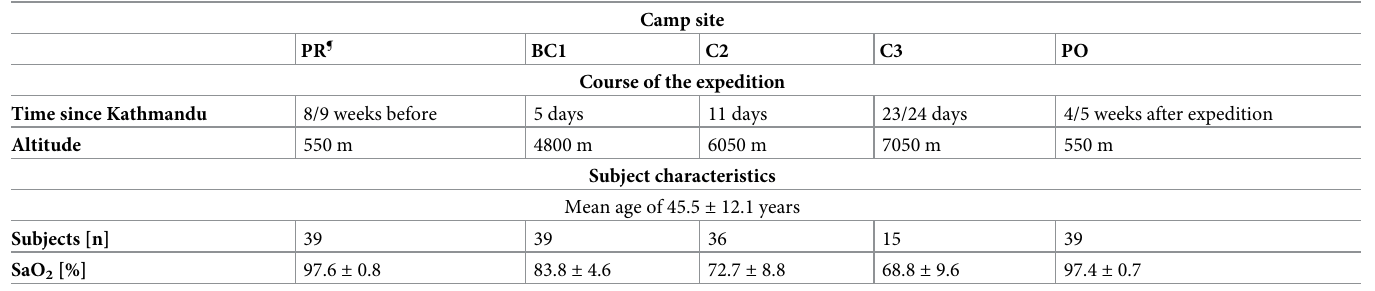
Table 1. Details of the time course of the expedition, study sites altitude, and subjects